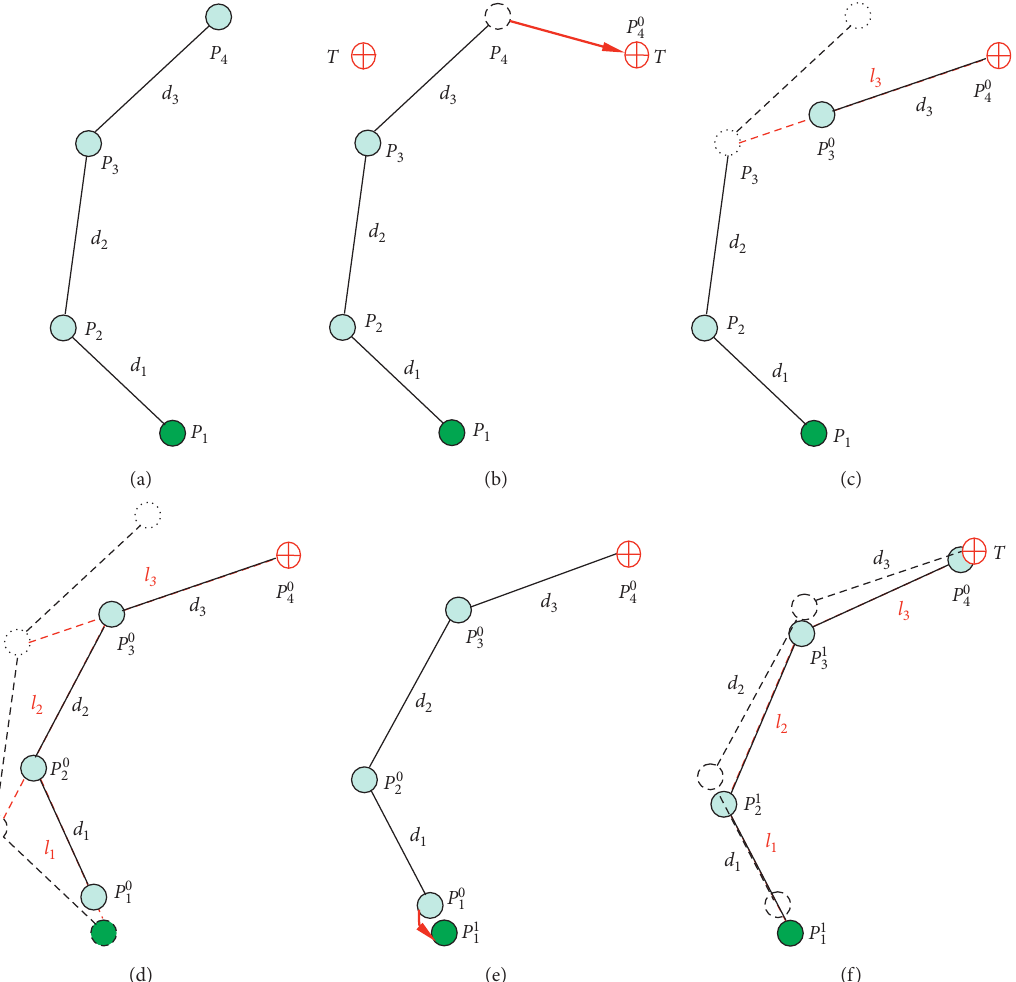
Figure 1: An example of a full iteration for a manipulator with a single target and four joints. (a) The initial state of the manipulator and the target position. (b) The end effector P 4 moved to the target position ( T ). (c) The middle joint P 3 ’s updated position P 30 . (d) The updated positions P 20 and P 10 . (e) P 10 moved to the initial position P 1 (P 11 is the updated position of P 10 ). (f) Updated positions P 21 , P 31 , and P 41